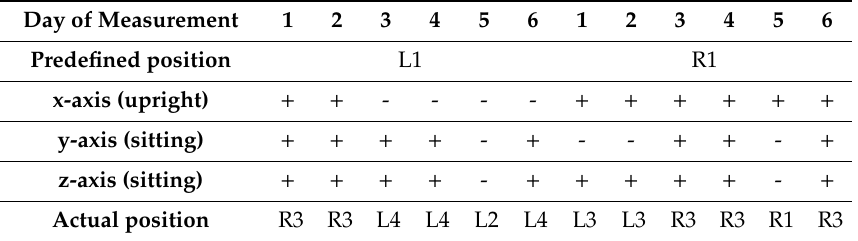
Table 2. Intended and actual position of accelerometers during the measurement of Subject 20. Day of Measurement